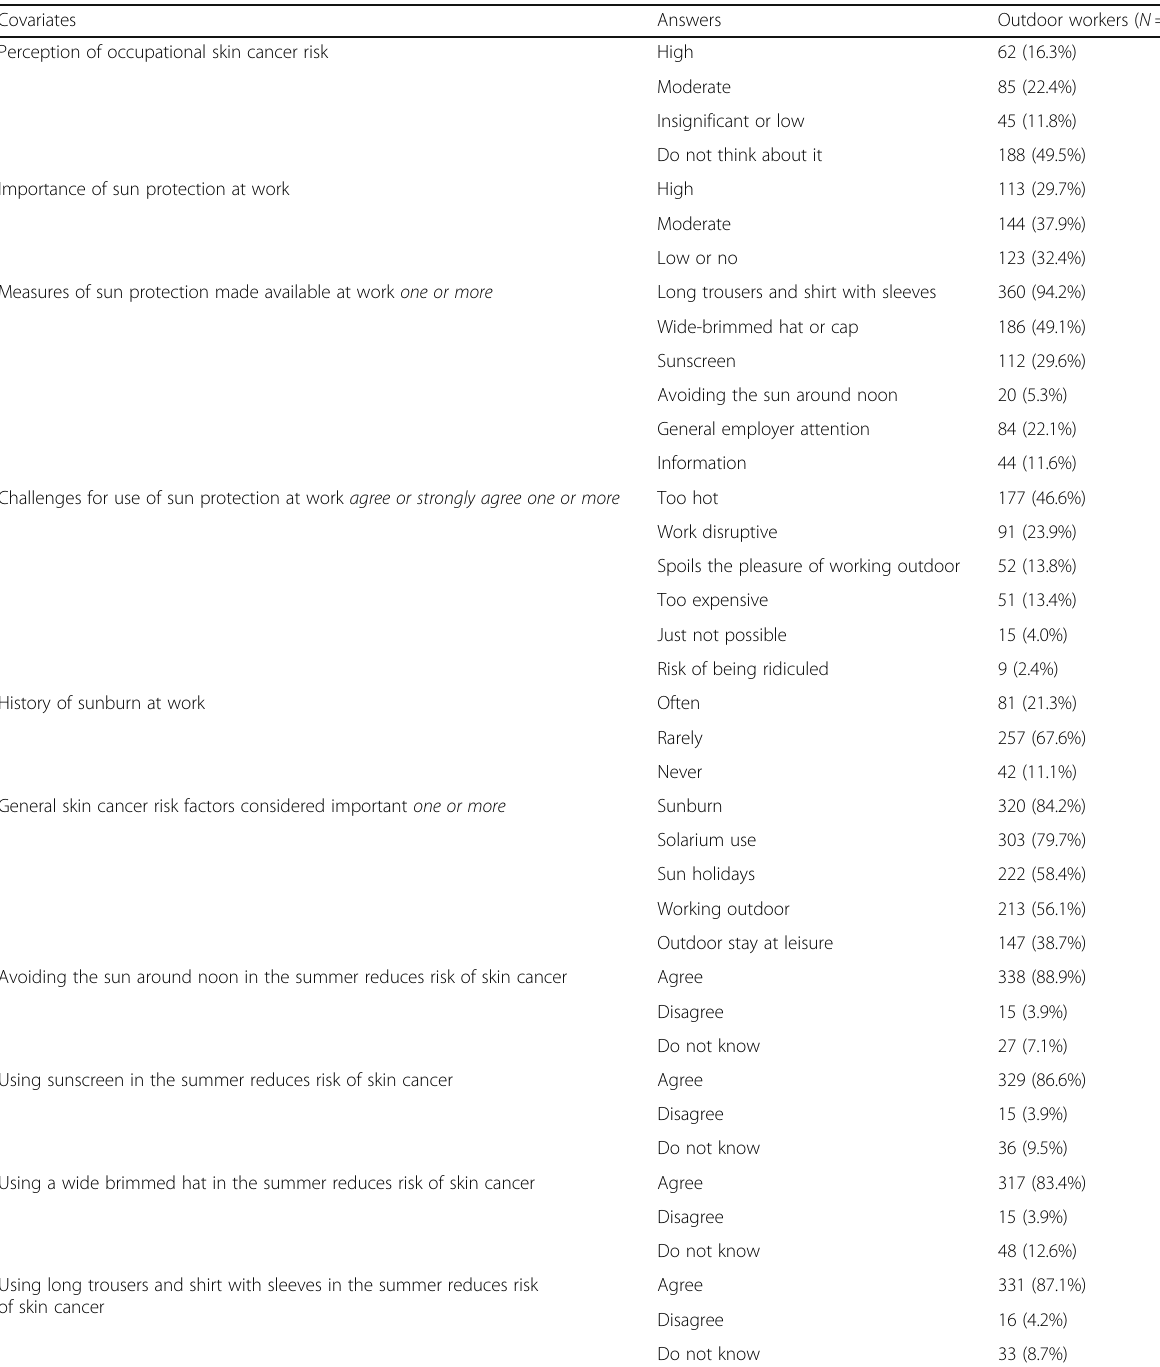
Table 2 Perception and attitude towards occupational skin cancer risk and sun protection